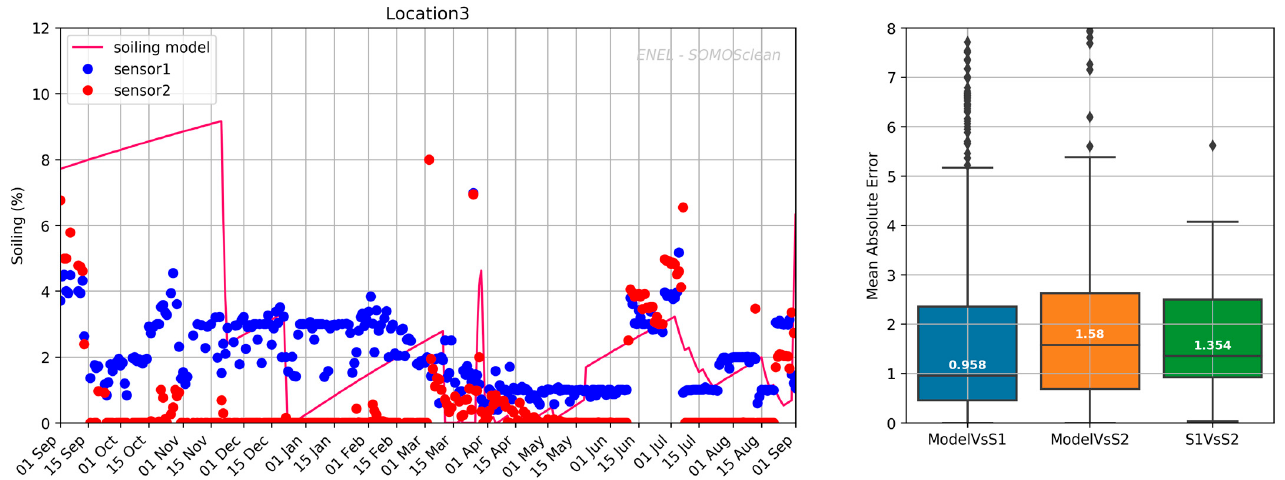
Figure A3. Soiling data from the power plant at location 3.